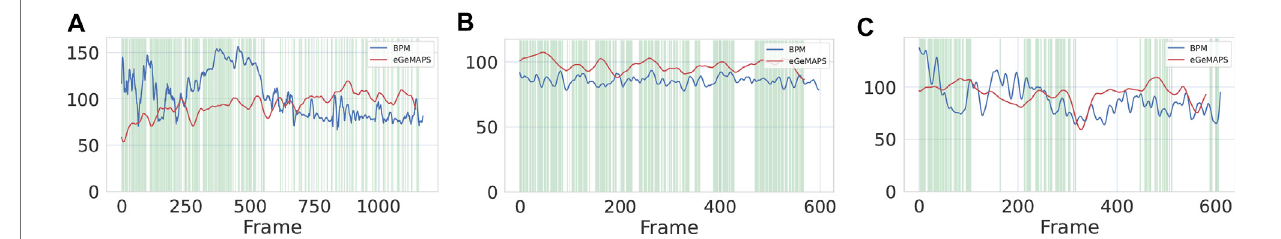
FIGURE 12 | Frame-wise BPM predictions vs ground truth for subject R-1 from the REG-TSST dataset and subjects U-39 and U-64 from the ULM-TSST dataset. Shaded(green)arearepresentssegmentsdetectedashavingspeechbytheVAD.Predictionshavebeensmoothedwithamovingaverage fi lterwithawindowsizeof30 for visibility. (A) R-1 BPM. (B) U-39 BPM. (C) U-64 BPM.